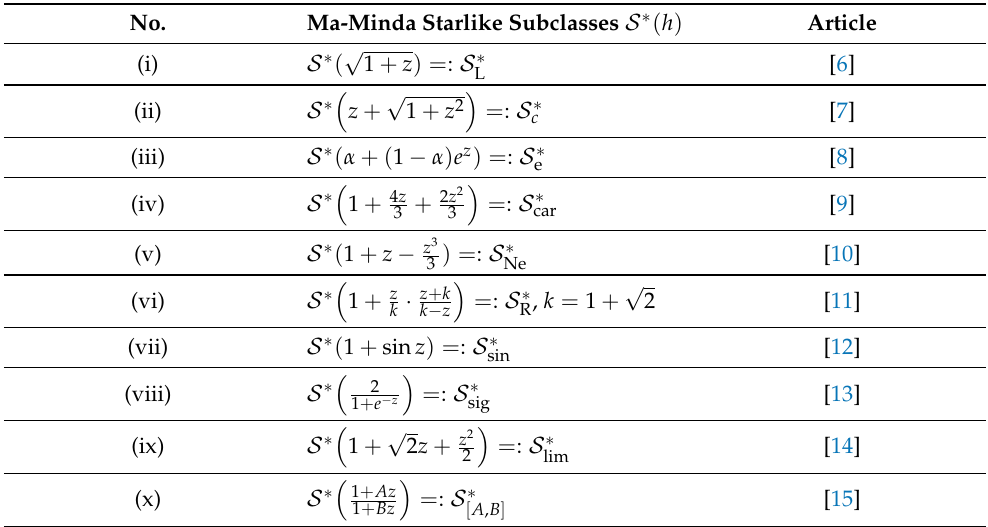
Table 1. Ma-Minda starlike subclasses S ∗ ( h ) .